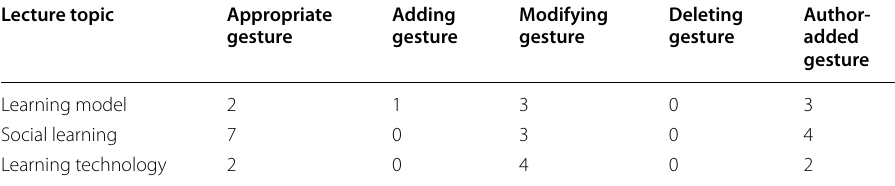
Table 3 Numbers of gestures reconstructed Lecture